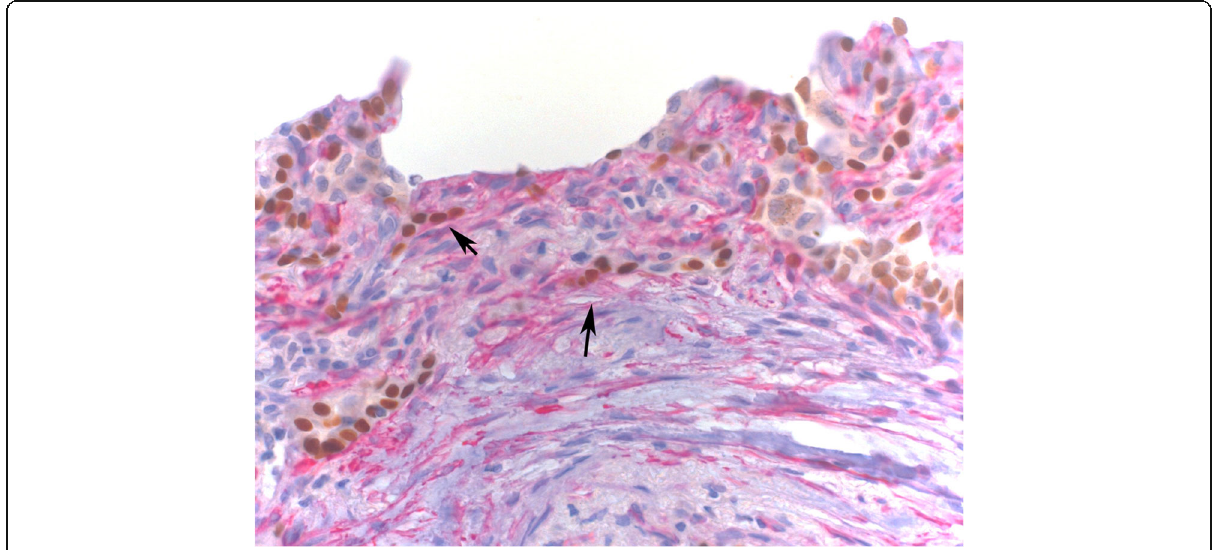
Fig. 8 UIP/IPF case, showing transition of epithelial or mesenchymal cells: TTF1 nuclear staining characterizes epithelial cells, whereas red filamentous staining for smooth muscle actin characterizes myofibroblasts. Arrows show cells coexpressing both markers. If these cells show epithelial-to-mesenchymal or mesenchymal-to-epithelial transition cannot be evaluated by morphology – both options might work. Magnification,